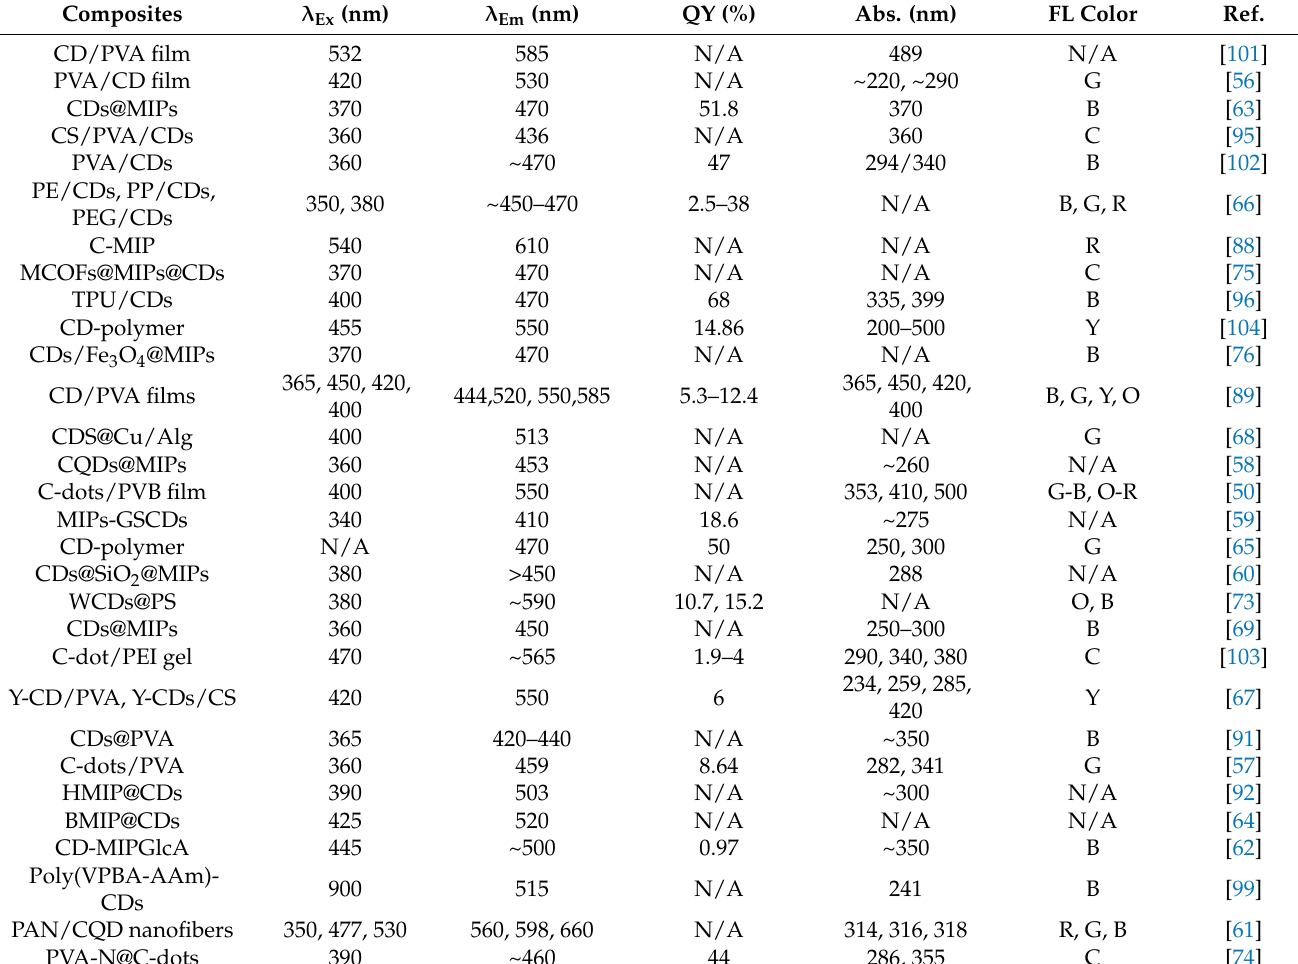
Table 3. The optical properties of several CD/polymer composites, including FL and UV–vis absorption properties.